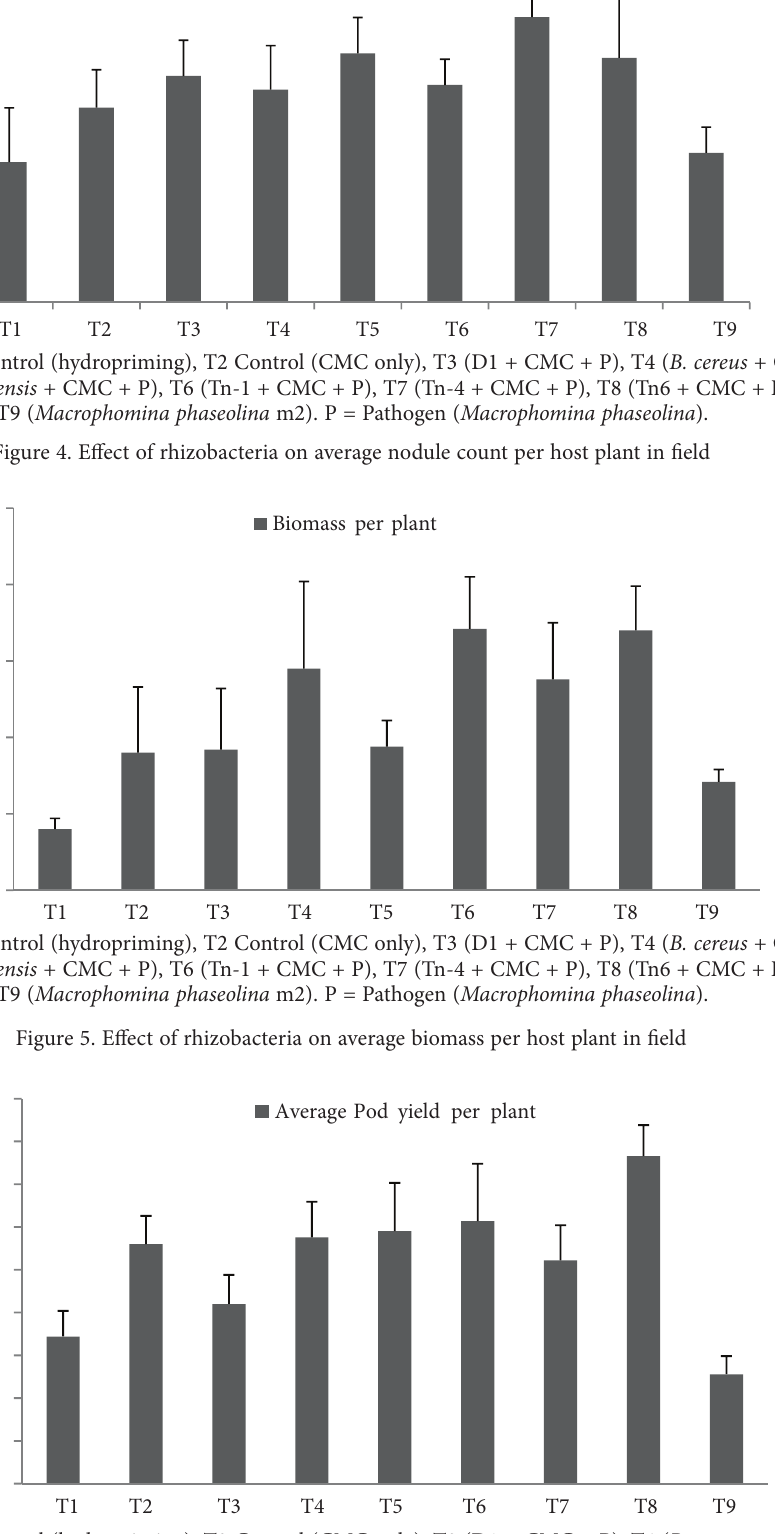
Figure 6. Effect of rhizobacteria on pod yield per plant in